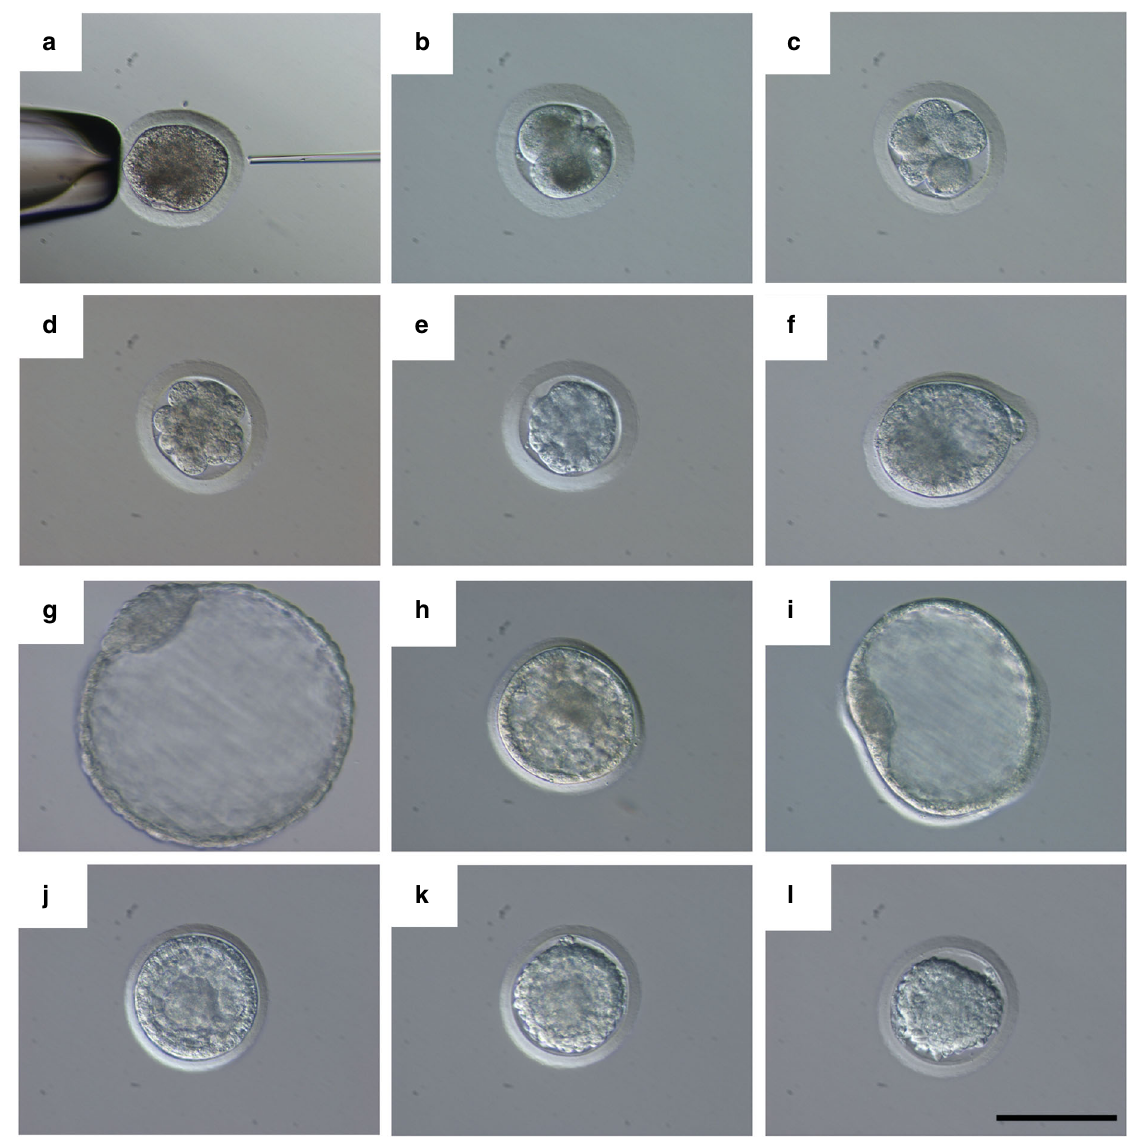
Fig. 2 Embryo development from ICSI to blastocyst stage. a ICSI was performed on MII oocytes with a Piezo-driven needle, the fi rst polar is visible at 6 o ’ clock, a sperm is visible inside the ICSI pipette ready for injection. A two-cell embryo 48 h after ICSI ( b ). Cleaved embryos developed to the eight cell stage on average 5 – 6 days after injection ( c ) and were at pre-compaction stage on day 5 – 7 ( d ). Compacted morulae were visible on average at day 7 – 9 ( e ). The fi rst blastocyst produced was a pure Southern White Embryo (fSWR5 × mSWR1, day 11 after ICSI) ( f ). The zona was removed by pronase digestion and embryo was left to expand for 2 days. From the isolated ICM of this embryo ( g ) and its twin obtained from the same group of oocytes (fSWR5 × mSWR1) two ES cell lines were derived. Subsequently Hybrid Southern White × Northern White blastocysts were obtained ( h ) (fSWR5 × mNWR1, day 9 after ICSI). One of these hybrid blastocysts (fSWR5 × mNWR2) naturally hatched from the zona at day 10 ( i ) and was used for ES cell derivation. One Southern blastocyst (fSWR4 × mSWR1) and two hybrid blastocysts (fSWR5 × mNWR2 and fSWR8 × mNWR2 ( j )) were frozen with a standard slow freezing protocol after equilibration in 5% and subsequently in 10% of glycerol freezing media (fSWR8× mNWR2 ( k , l )). Scale bar corresponds to 100 µ